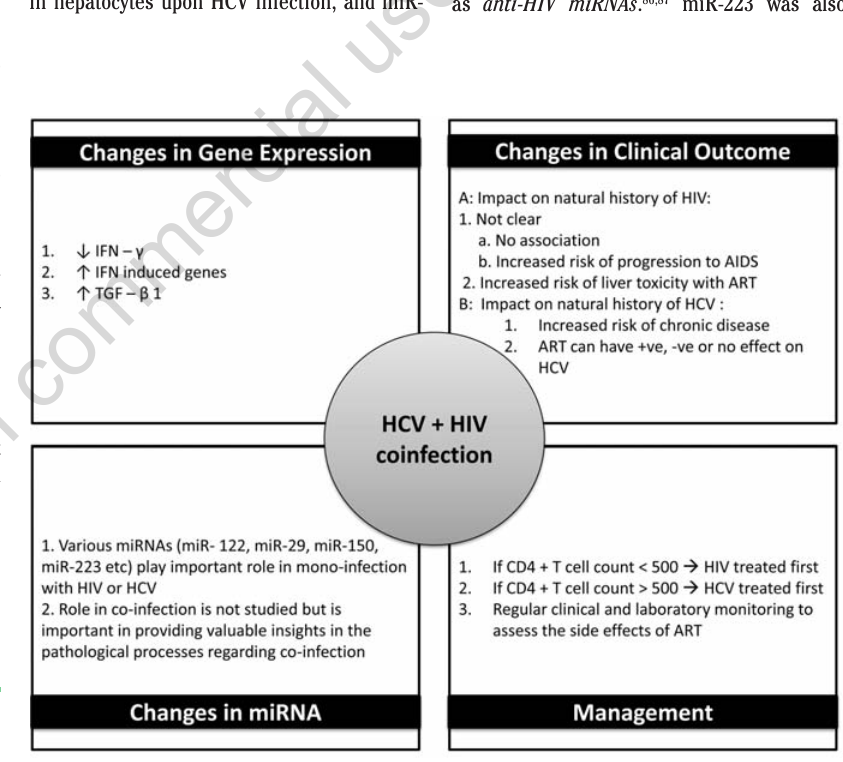
Figure 1. Summary of key findings in HIV-Hepatitis C virus co-infection discussed in the review. The gene expression studies show decreased level of Interferon (IFN)- γ , increased level of Tumor Growth Factor (TGF)- β 1 and increased level of IFIG (interferon induced genes). So far, there have been no miRNA expression studies and there is a need to explore the role of miRNA in the co-infection. The impact of HCV on HIV is not clear and needs to be further explored. HIV has negative impact on HCV with three times greater risk of progression to liver disease in co-infected patients than those infected with HCV alone. The management of co-infection is directly related to the CD4+ T cell count. Regular clin- ical and laboratory monitoring for the side effects of Antiretroviral therapy (ART) should be done to avoid liver toxicity in co-infected